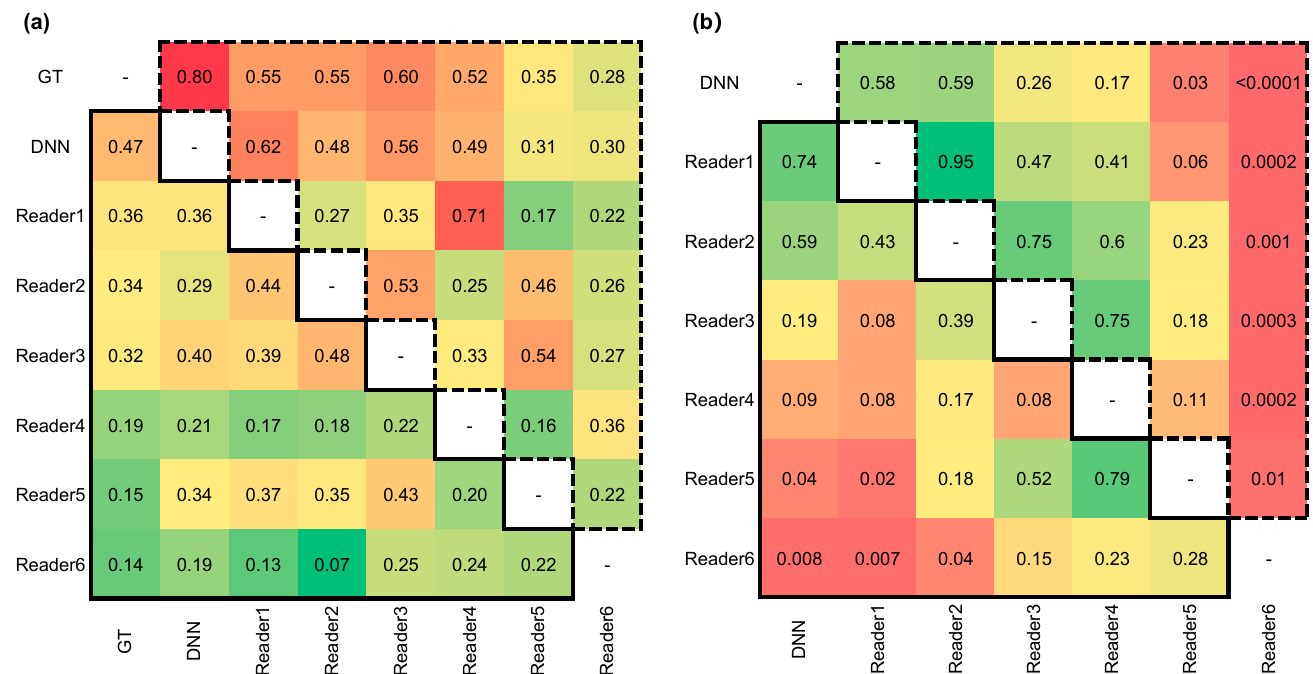
solid line triangle on the bottom left corner represent Task1 testing results. The statistical values contained in a dashed line